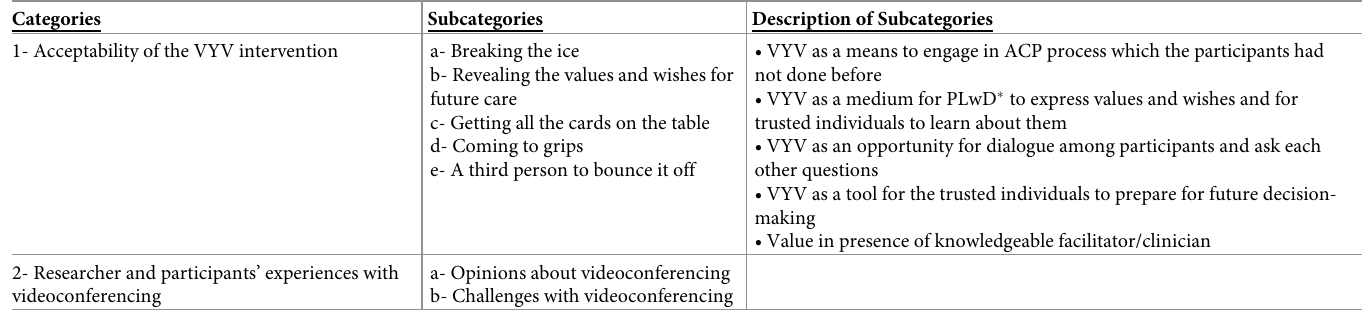
Table 4. Categories and subcategories related to the acceptability of experiences with